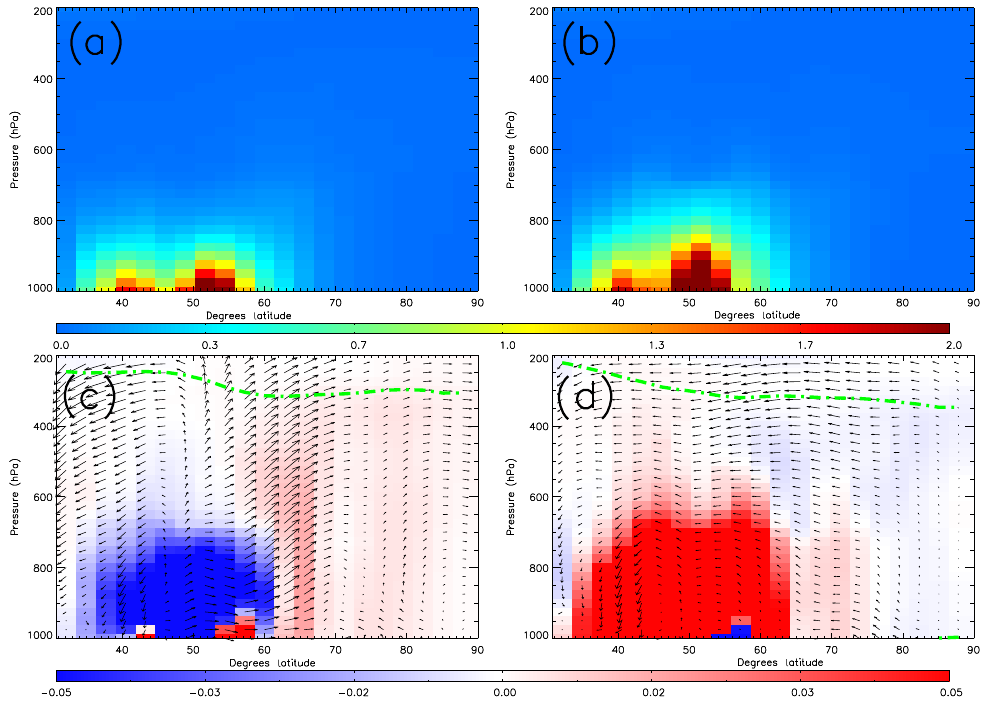
Figure 8. TOMCAT NO 2 (ppbv) cross section at 0 ◦ E averaged between 2006 and 2015 sampled under the wintertime (NDJF) NAO. (a) NAO positive phase, (b) NAO negative phase, (c) shows the NAO positive phase anomaly relative to the wintertime average and (d) shows the negative NAO phase anomaly relative to the wintertime average. Green dashed lines represents the dynamical tropopause. Wind vectors represent the cross section (0 ◦ E) meridional and vertical (scaled by 10 4 )